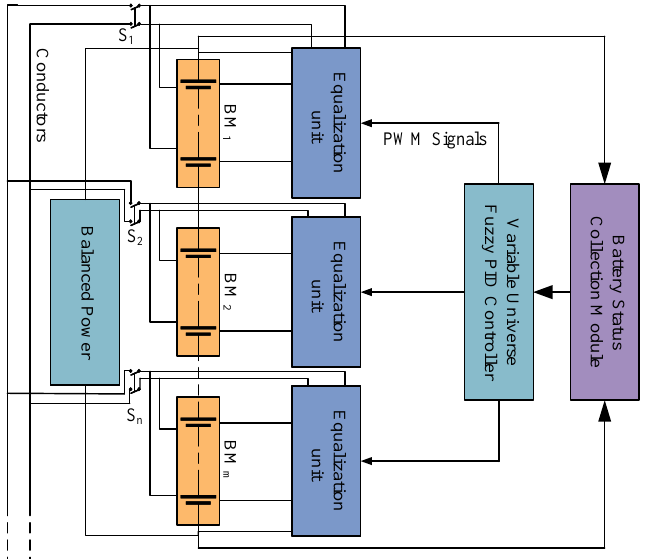
Figure 1. Overall structure of the equalization scenario. As shown in Figure 1, each module is connected by wires, and the module that needs to be turned on for equalization is selected by switch S . Figure 2 depicts the module’s internal structure, including double-layer switches K ( K 1 a , K 1 b . . . . . . K na , K nb ) , Q ( Q 1 a , Q Q na , Q nb ) and equalization circuit. In the process of operating the single 1 b . . . . . . cell that is required to be equalized, the upper switch Q and the lower switch K are wired to their respective negative and positive ends. The equalization network also features a